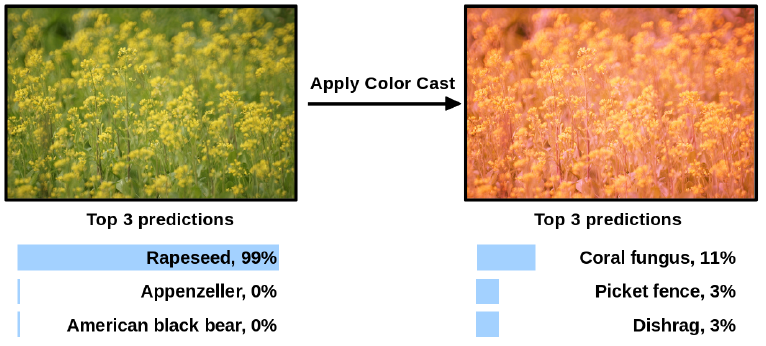
Figure 1. Example of correctly predicted image and mis-predicted image after a color cast is